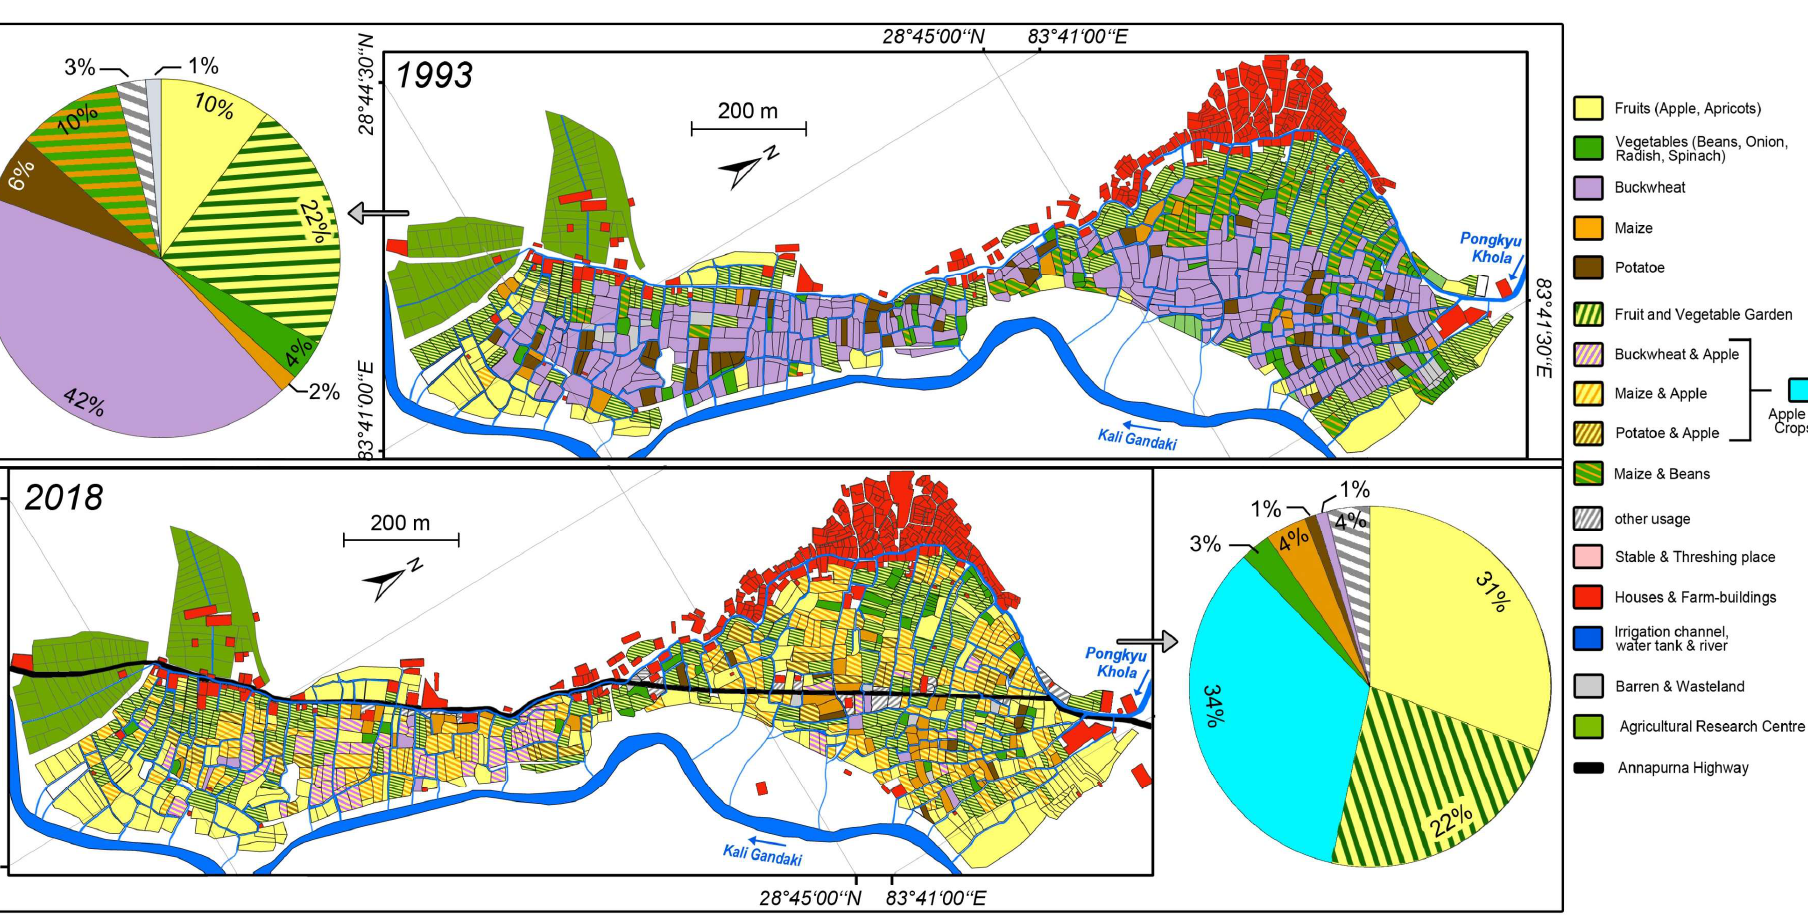
Figure 7. Land use at Marpha settlement during the autumn season in 1993 and 2018. Pie charts represent the relative area of the various crops in relation to the total arable land. The intercropping of apples with buckwheat, maize, and potatoes are grouped as cyan within the pie chart. The underlying detailed on-site mappings were performed in Oct. 1993 and Oct. 2018, respectively. Projection WGS 1984 UTM Zone 44N (scale 1:11,600).